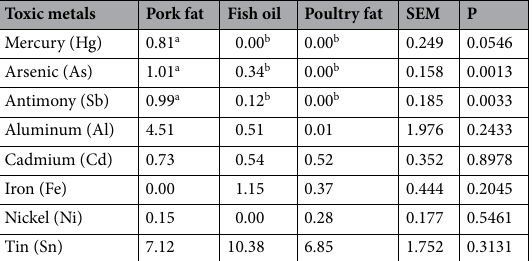
Table 13. Detected toxic metals concentrations (mg/kg) in the evaluated fat sources. SEM standard error mean, P probability of significance. a,b Means followed by different letters in the lines differed (P < 0.05) by tukey